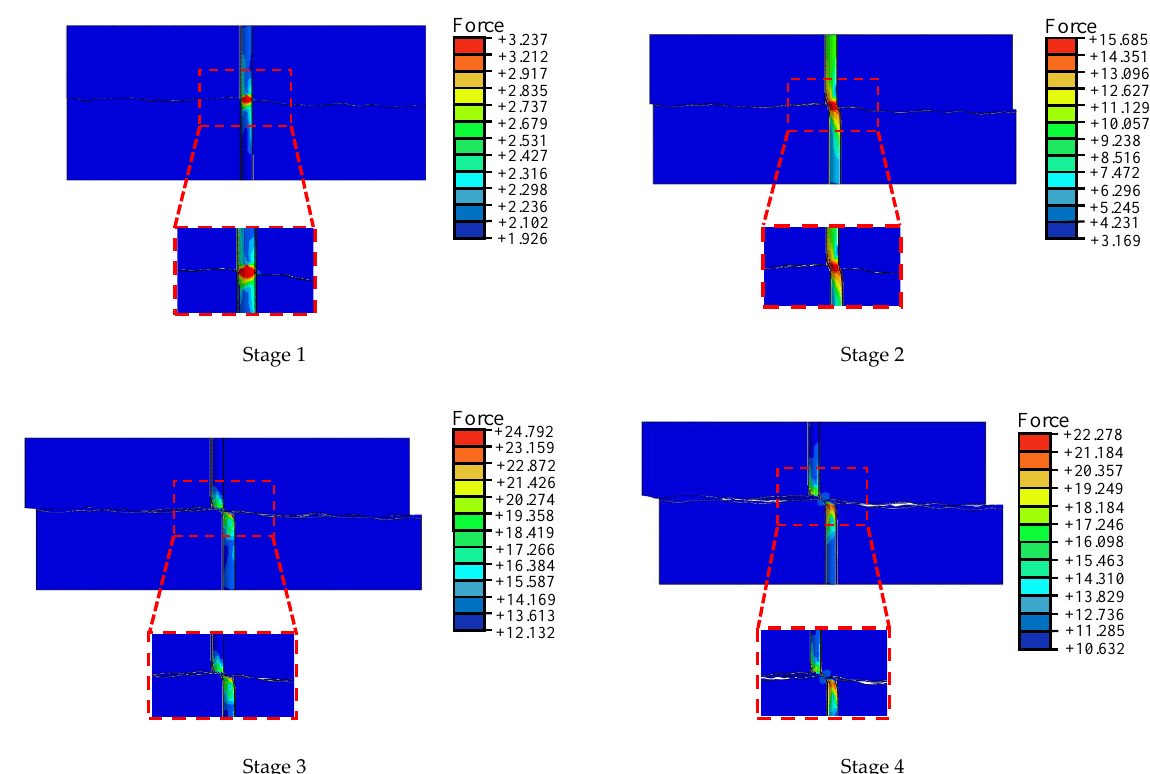
Figure 15. Local failure of the shear upper and lower plates and wellbore .